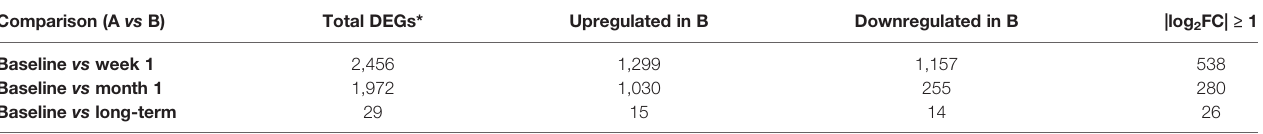
TABLE 2A | Differential expression results for patients with